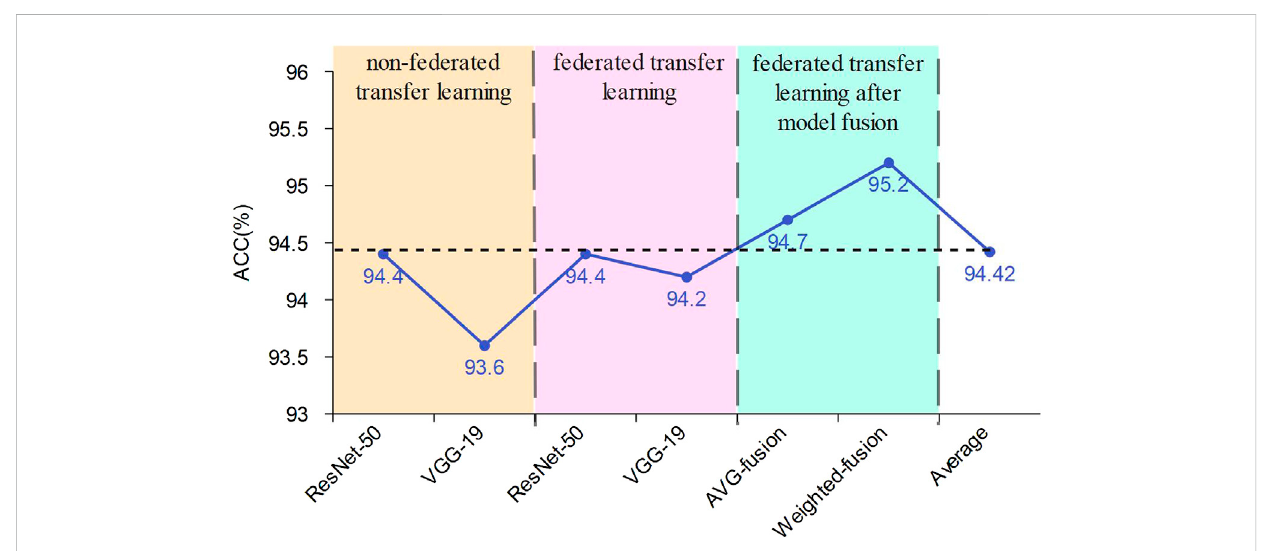
FIGURE 6 The speci fi c experimental comparison